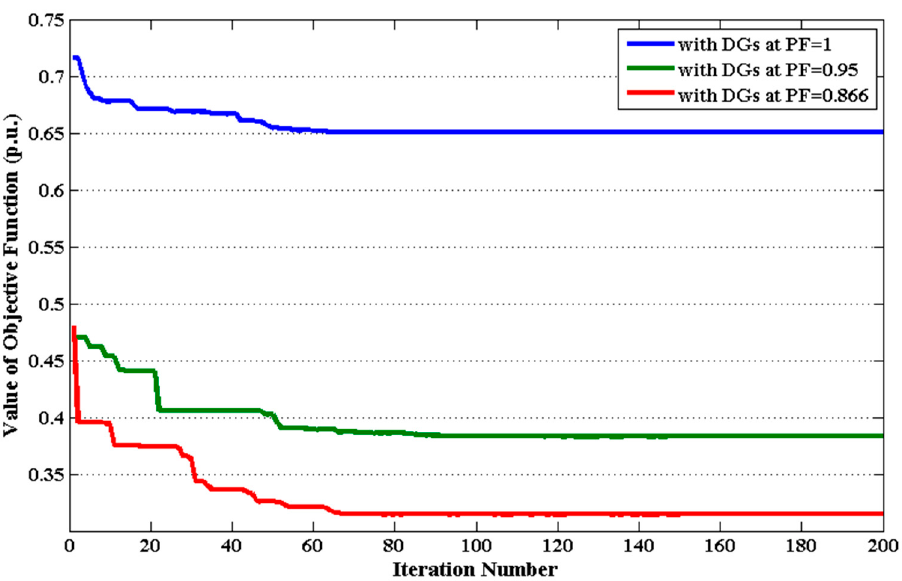
Figure 9. Convergence characteristics for Case 3 of the IEEE 33-bus system using QODELFA.